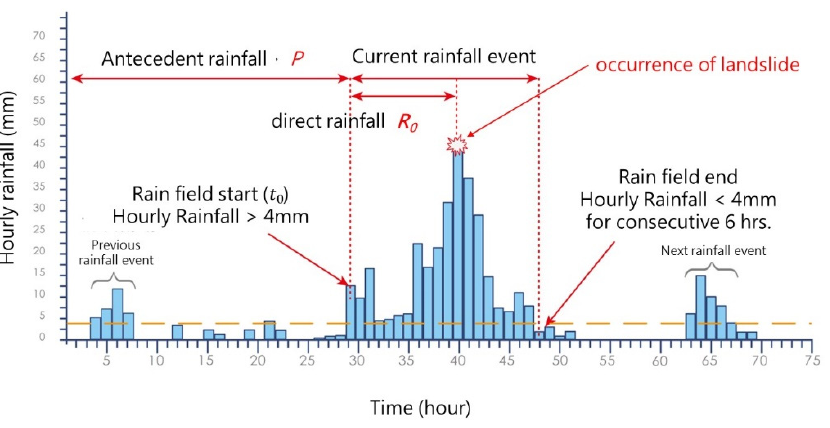
Figure 2. Schematic diagram of rain field cutting (modified from: [76]).